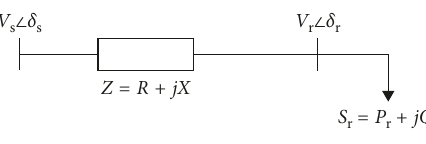
Figure 1: Two-bus